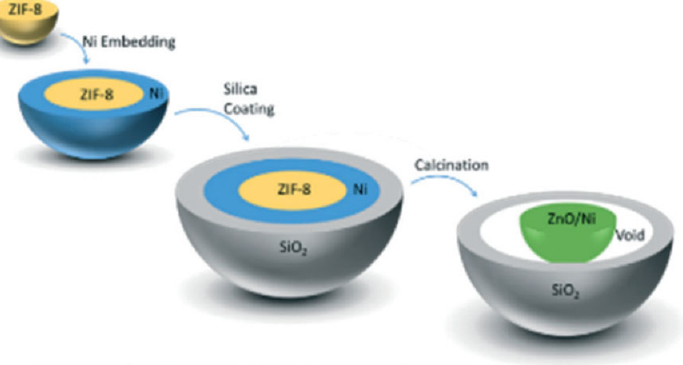
Figure 19. Schematic illustration of the preparation procedure followed to obtain the ZnO/Ni@m ‐ SiO 2 core–shell catalyst. Adapted from Ref.